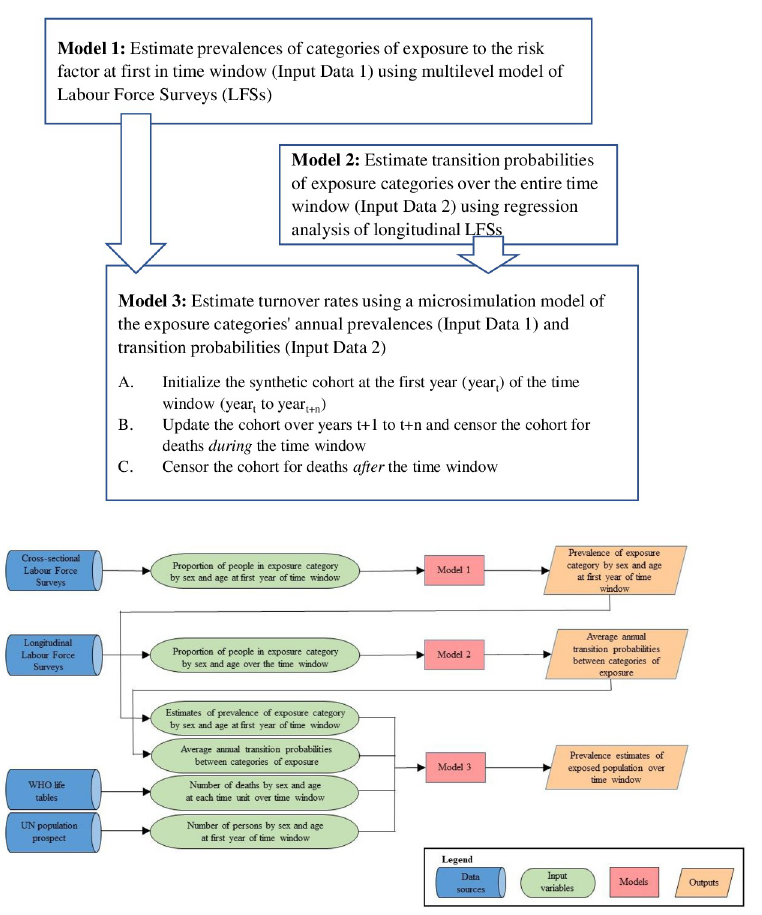
Fig 2. Flow diagram of the data sources and modelling approach. a) Overview of the steps of the method to estimate prevalence of exposure to an occupational risk factor over a time window. b) Flow diagram of the data sources and modelling